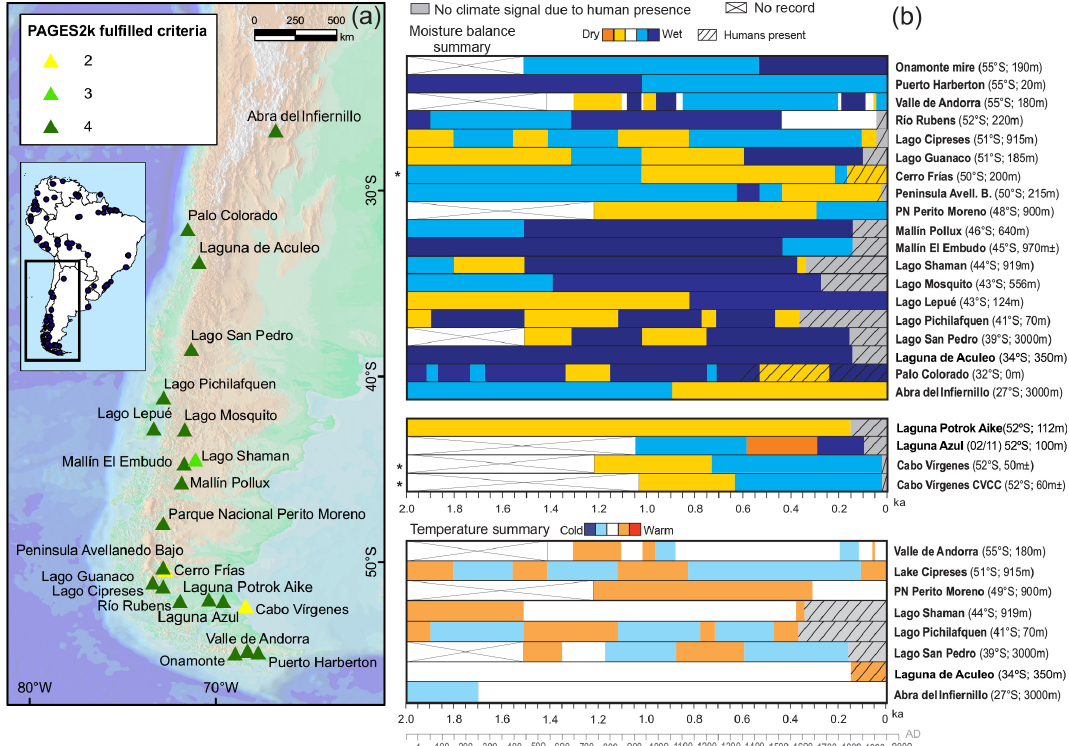
Figure 13. Panel (a) : map showing the pollen records discussed in the Southern Andes and Patagonia and the number of PAGES-2k criteria these records fulfill. Panel (b) : summary of moisture balance and temperature including human interference for the pollen records discussed. Not all records are suitable to derive both a moisture and a temperature signal. Climate and human presence are shown overlapping when the pollen record is not conclusive regarding the derived signal. Bars are shaded grey when the climate signal is obscured by human interference. Records fulfilling one or two criteria indicated by star; m ± : ma.s.l. based on